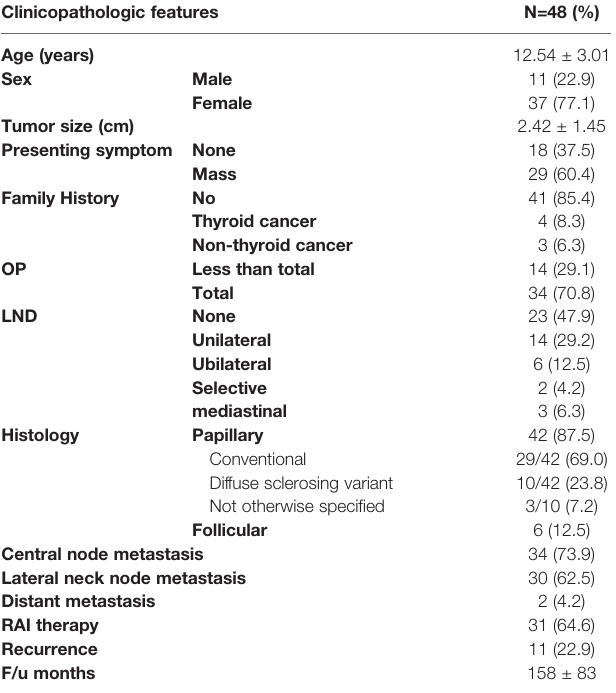
TABLE 1 | The baseline clinical characteristics of 48 pediatric